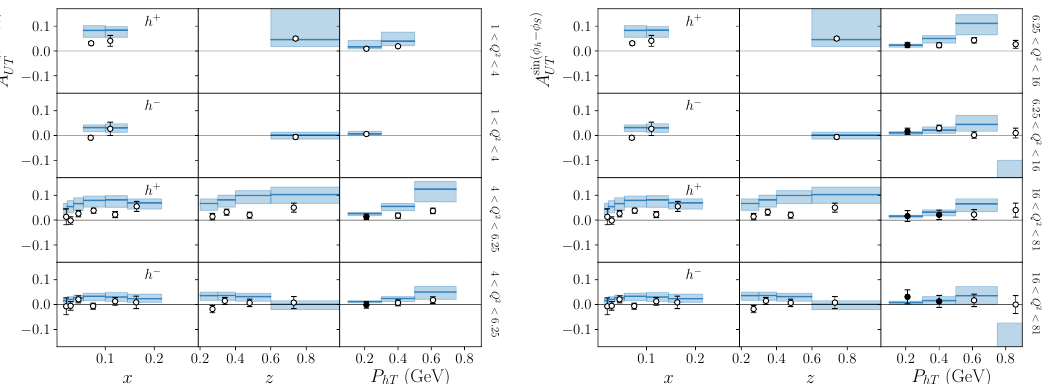
Figure 10. Description of multi-dimensional COMPASS SIDIS proton data [39]. Sivers asymmetry for z > 0 . 1 in the four Q 2 -ranges as a function of x , z and P for unidentified charged hadrons h ± , hT only data with δ < 0 . 5 are shown. Solid (open) symbols data used (not used) in the fit. Blue line is the CF and the blue box is 68%CI of the fit of the data and prediction for the data not used in the fit.